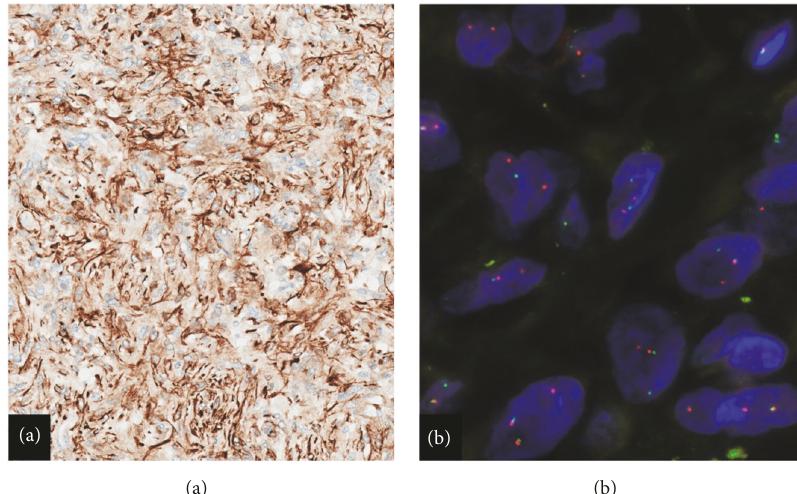
Figure 5: (a) Immunohistochemistry: desmin, lesional cells diffusely immunoreactive (20X). (b) Fluorescence in situ hybridization with a dual-color break-apart probe flanking the EWSR1 gene on chromosome 22q12. A separate red and green signal indicates a rearrangement involving EWSR1 and is identified in the lesional cells (100X).